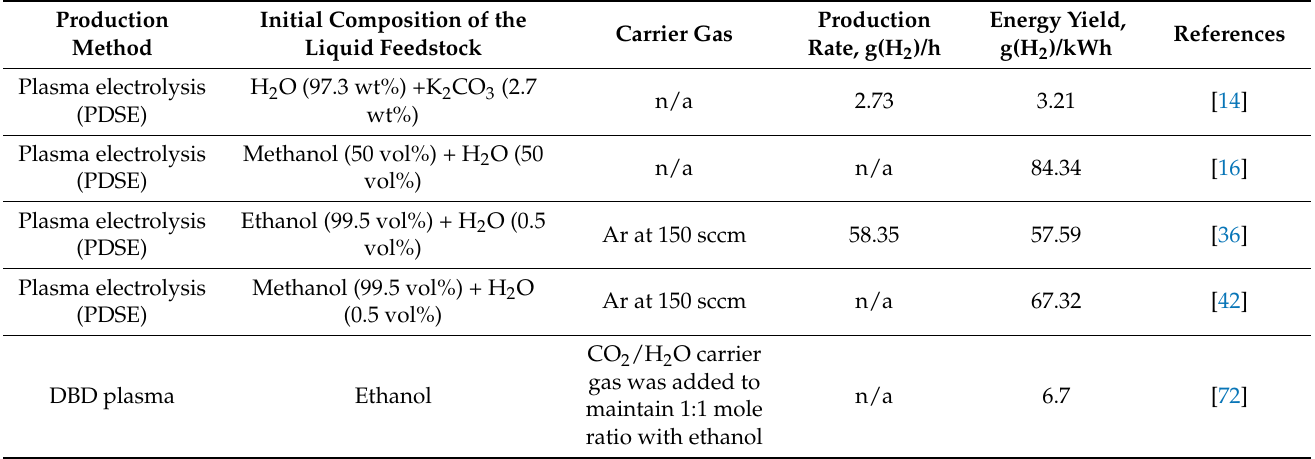
Table 4. Comparison of hydrogen production in PDSE of different types of the electrolytic solutions with hydrogen production by other plasma-assisted methods.